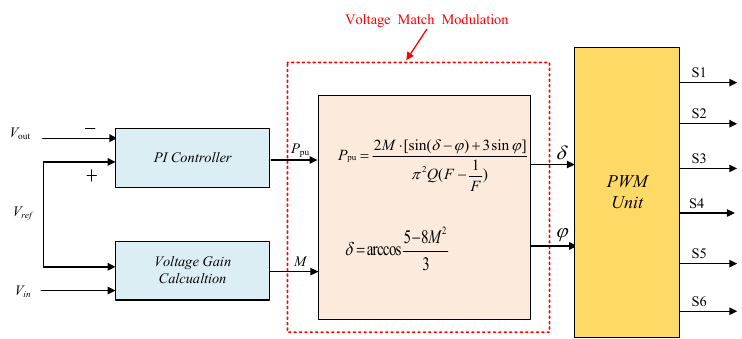
Figure 8. Implementation of the proposed VMM